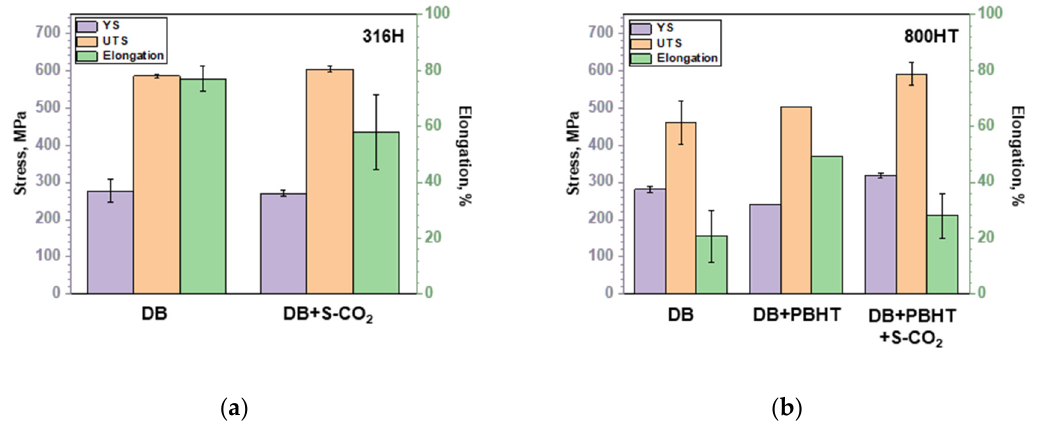
Figure 6. Room temperature tensile test results of ( a ) diffusion bonded SS 316H and ( b ) PBHT ‐ ed Alloy 800HT after S ‐ CO 2 exposure at 600 °C (20 MPa) for 1000 h.